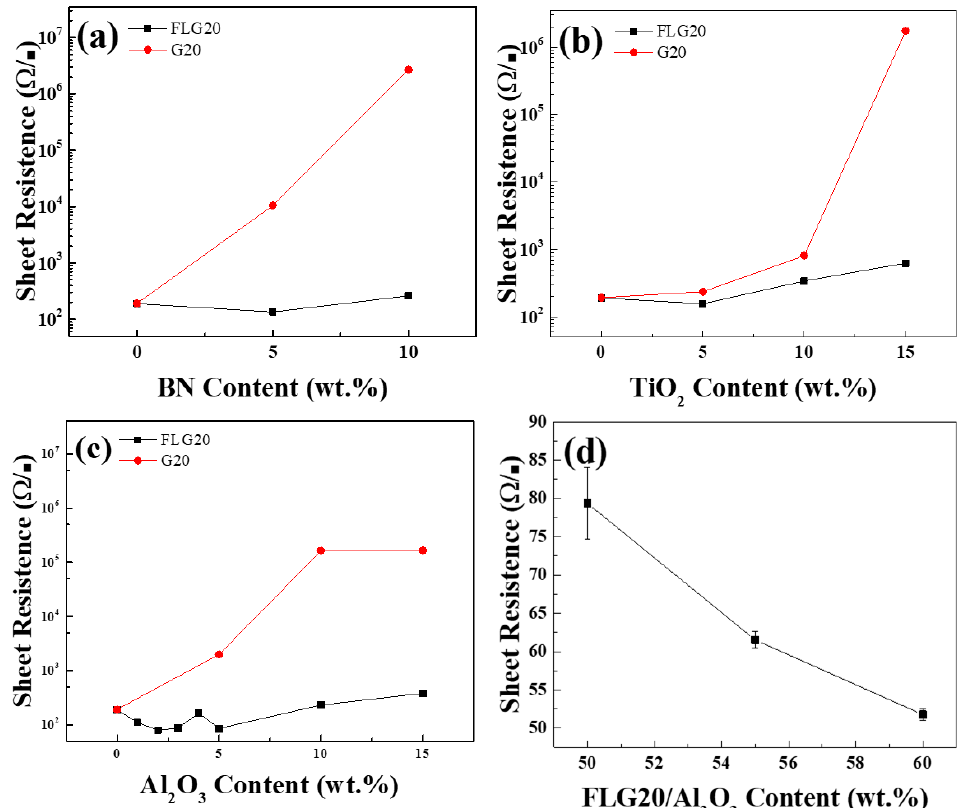
Figure 7. Sheet resistance of electrically conductive adhesives (ECAs) filled with different proportions of ( a ) BN, ( b ) TiO 2 , and ( c ) Al 2 O 3 . ( d ) Different FLG20/Al 2 O 3 solid contents.